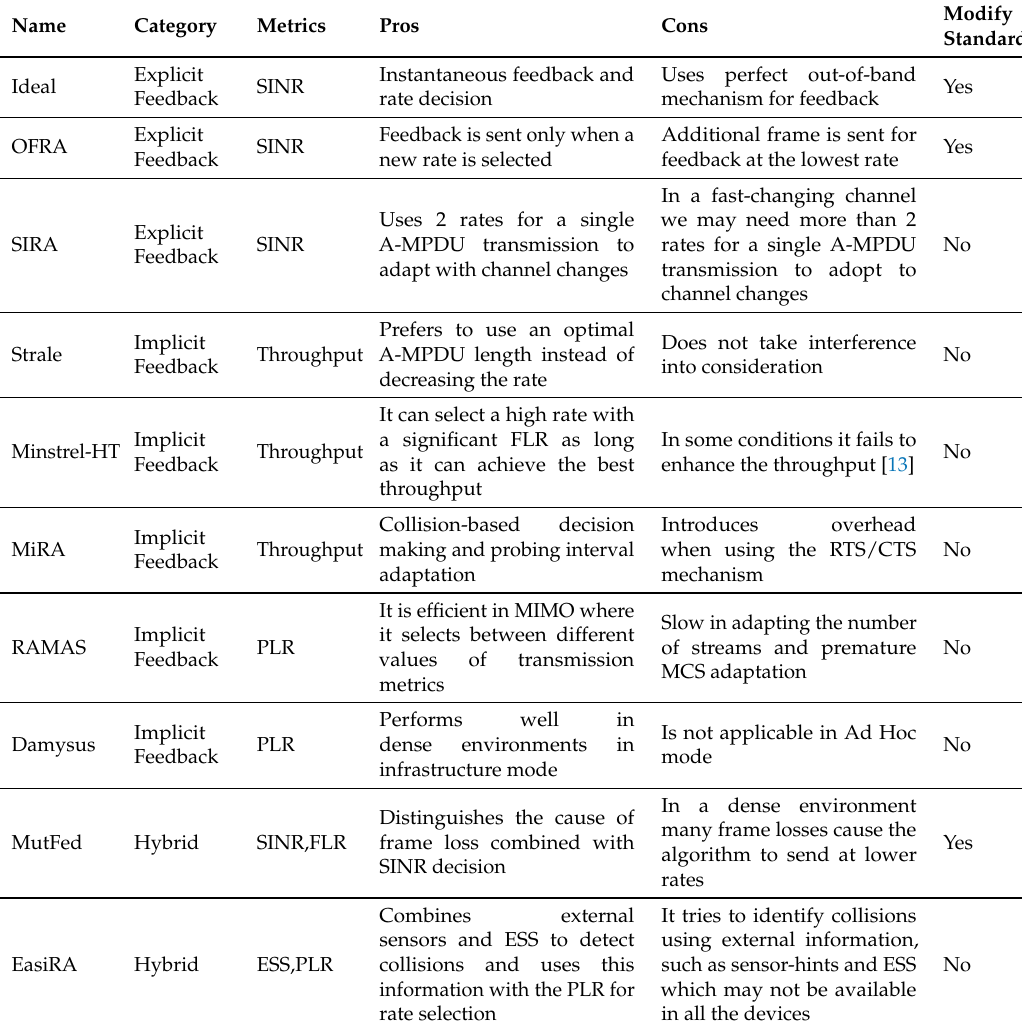
Table 1. Summary of existing rate adaptation